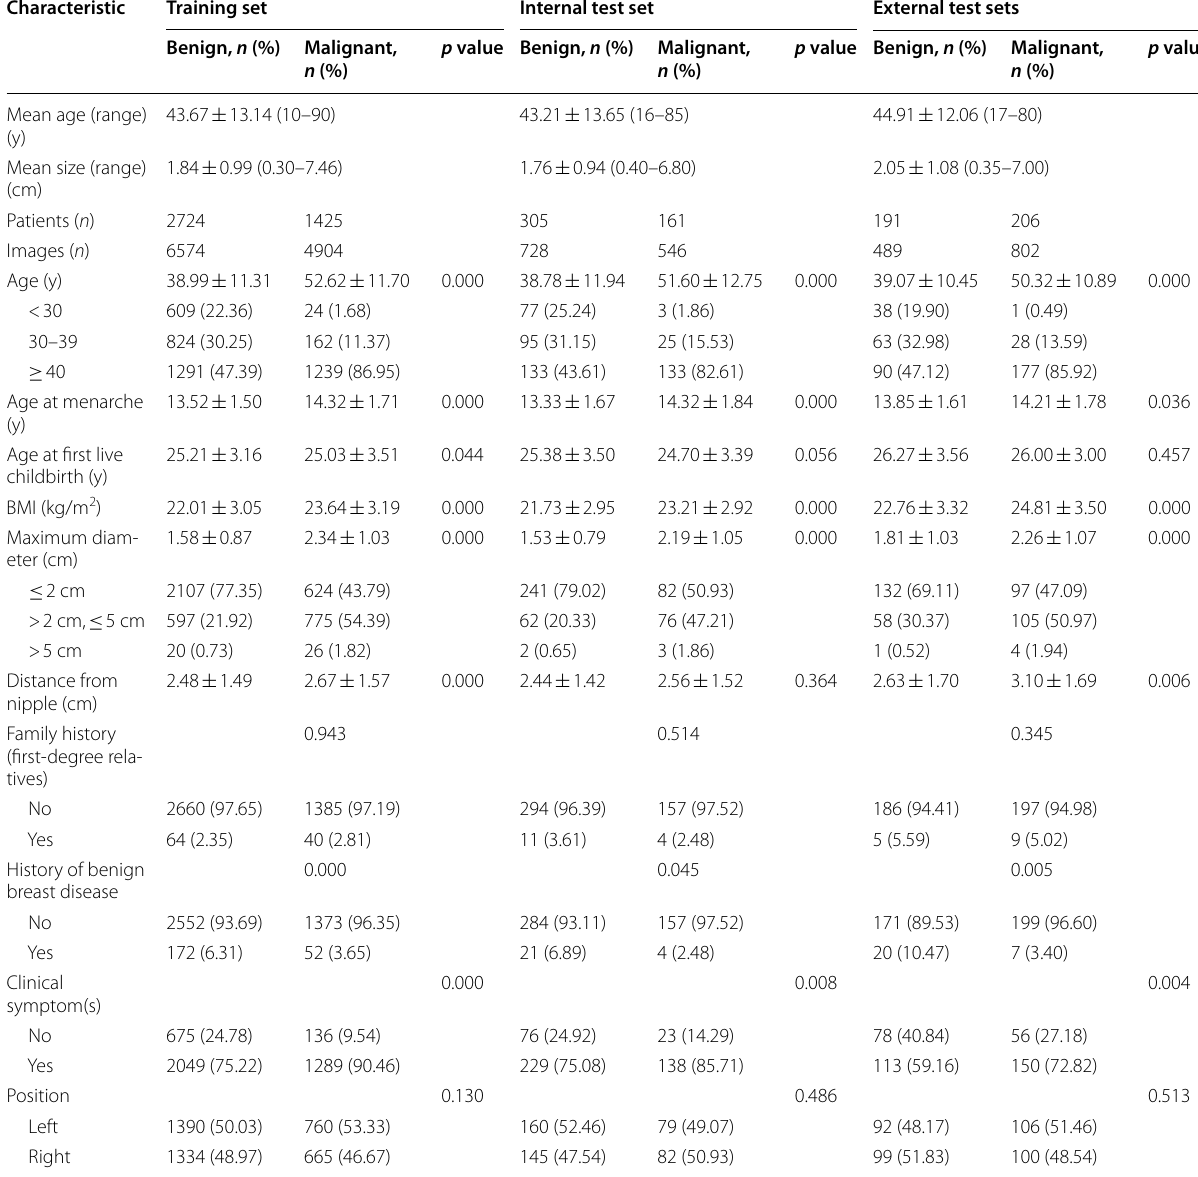
Table 1 Patient demographics and breast lesion